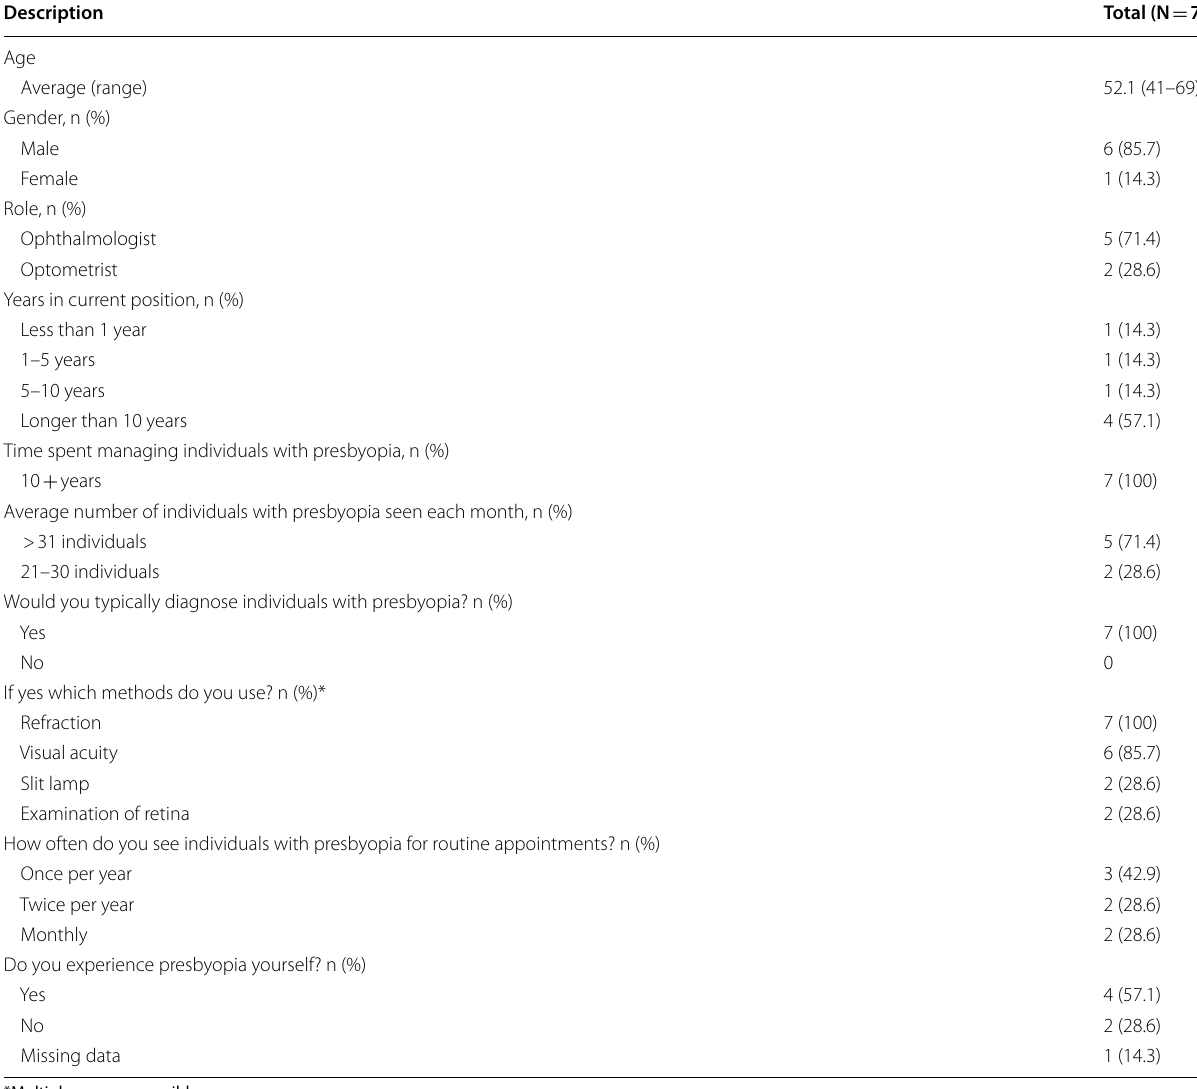
Table 1 Healthcare professional demographic